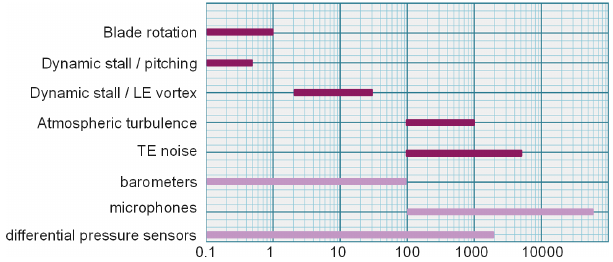
Figure 2. Dynamics of the physical features that should be mea- sured by the Aerosense system and the range of frequencies that the sensors can acquire. The horizontal axis is in Hertz (Hz) and on a log scale. LE and TE denote leading edge and trailing edge,